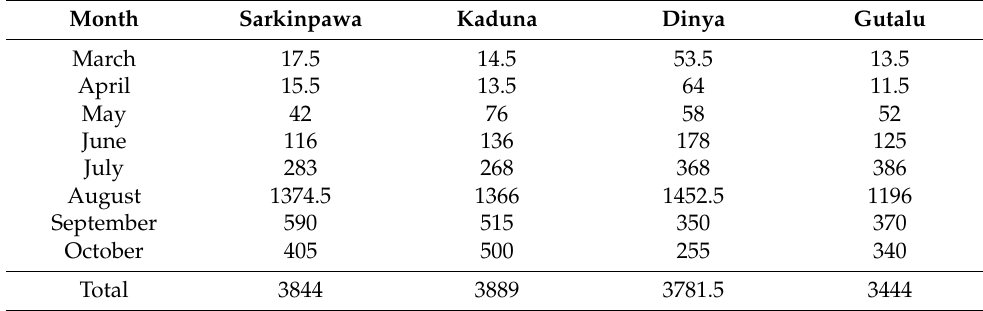
Table A3. Temporal variation of suspended sediment concentration (mg/L) of Kaduna watershed. Month Sarkinpawa Kaduna Dinya